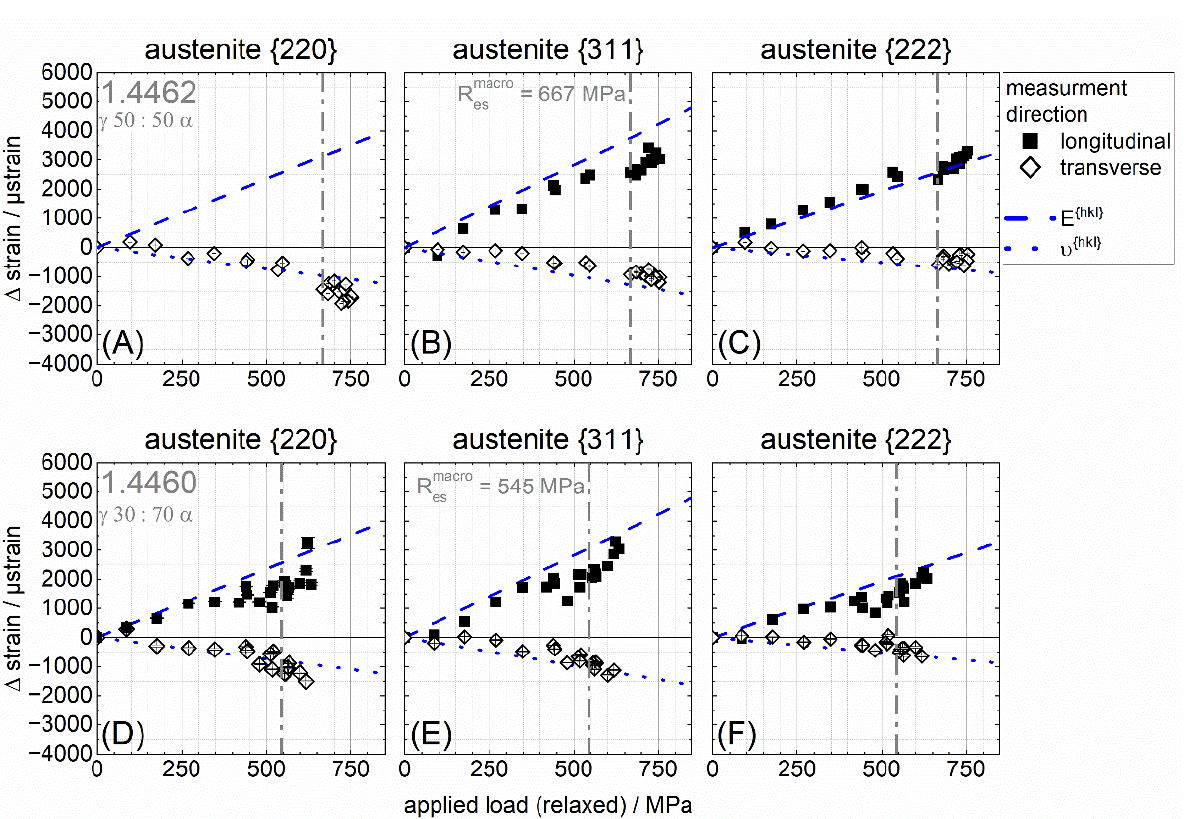
Figure 8. Evolution of lattice strain vs. applied load stress for the austenite phase in both duplex stainless steels. ( A – C ) Duplex stainless steel 1.4462; ( D – F ) steel 1.4460. The lattice strain vs. applied load distributions of the ferrite phase are shown